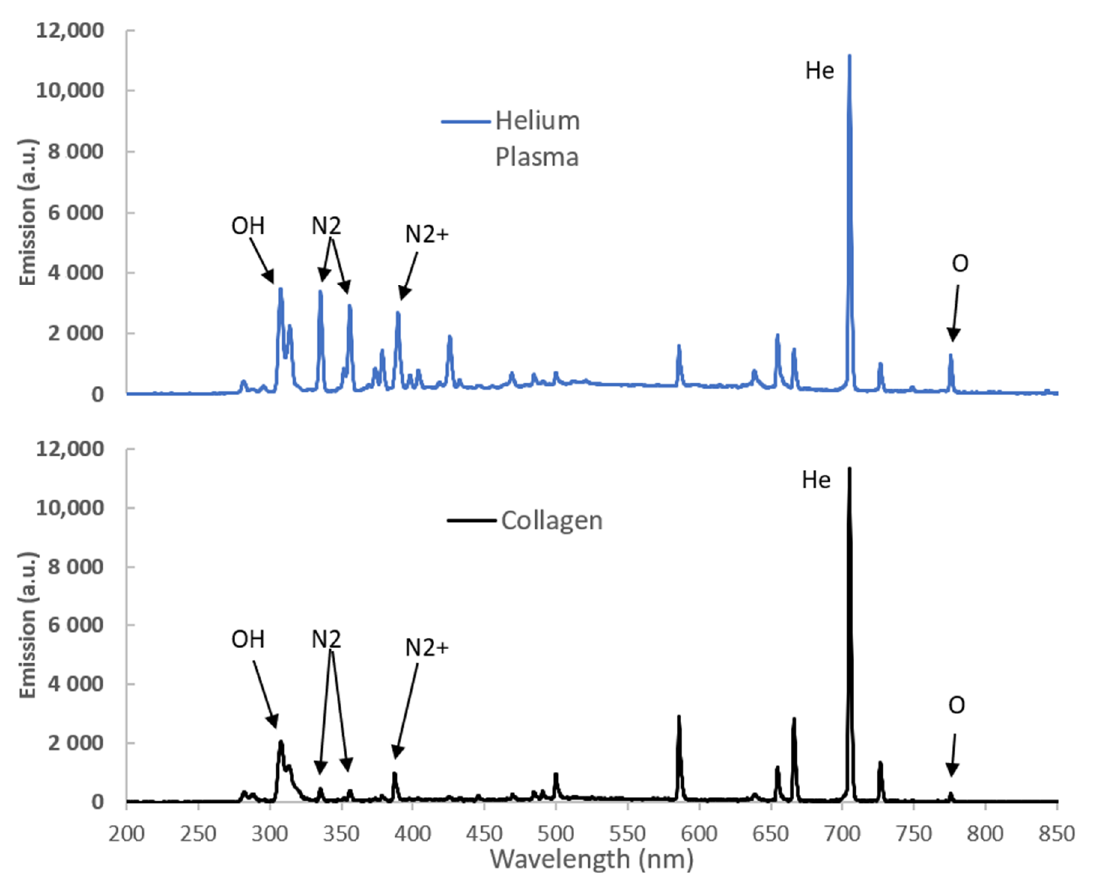
Figure 4. Typical optical emission spectra collected from pure helium plasma ( top ) and plasma with collagen aerosol ( lower ).